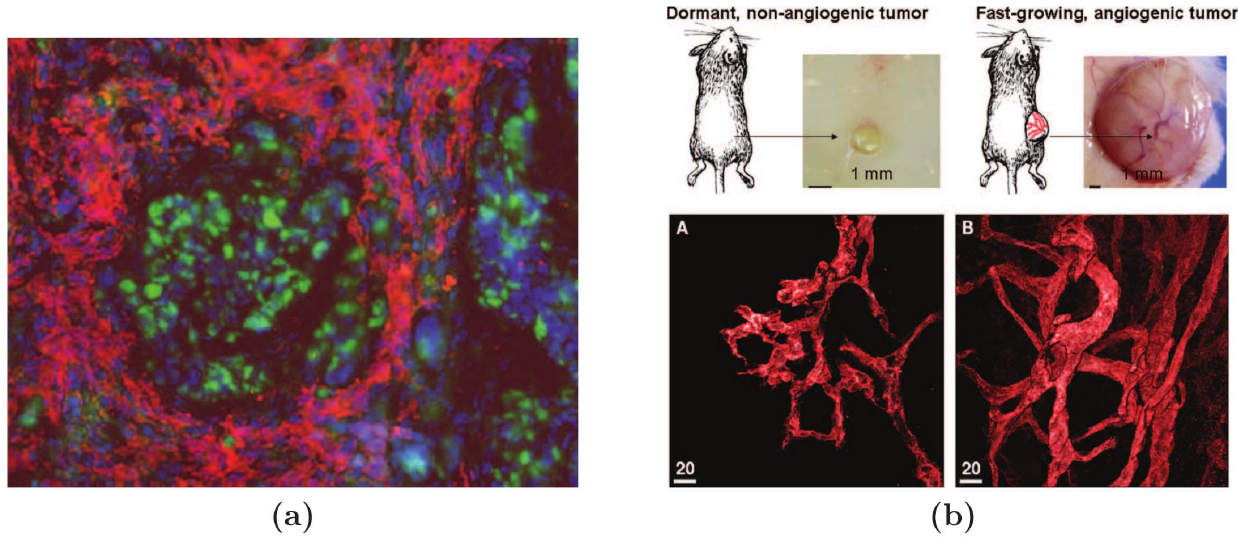
Figure 1. Fluorescence micrograph of a breast tumor stained to visualize carcinoma cells (phospho-p53, green) surrounded by macrophages (CD11b, red) (a). Nuclei appear blue (DAPI). Image courtesy of Michael Graham Espey, PhD, National Cancer Institute, NIH (private communication). (b) Representative pictures of dormant and fast-growing tumors and their vascular structure. Reprinted from Cancer Letters, 294, Almog N, Molecular mechanisms underlying tumor dormancy, 139–146, Copyright (2010), with permission from Elsevier.